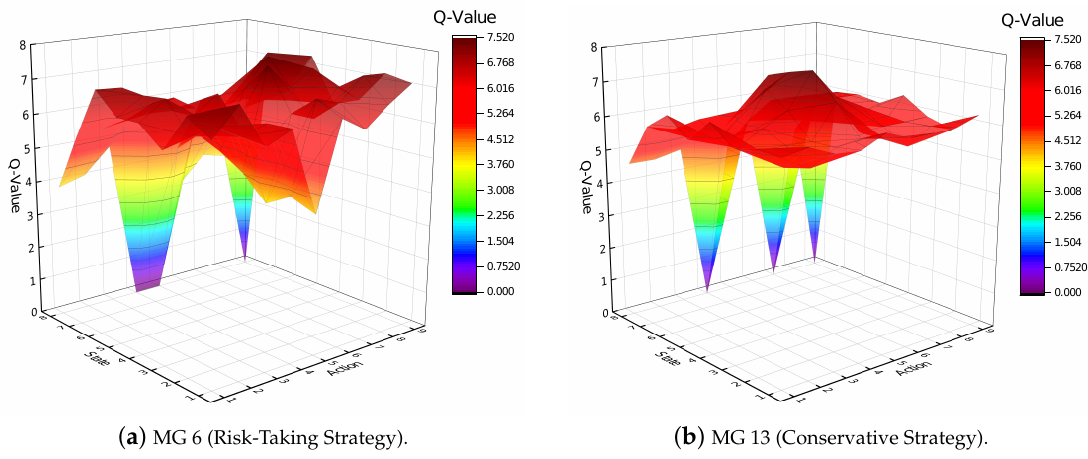
Figure 15. The Q-value distribution of microgrids adopting two risk